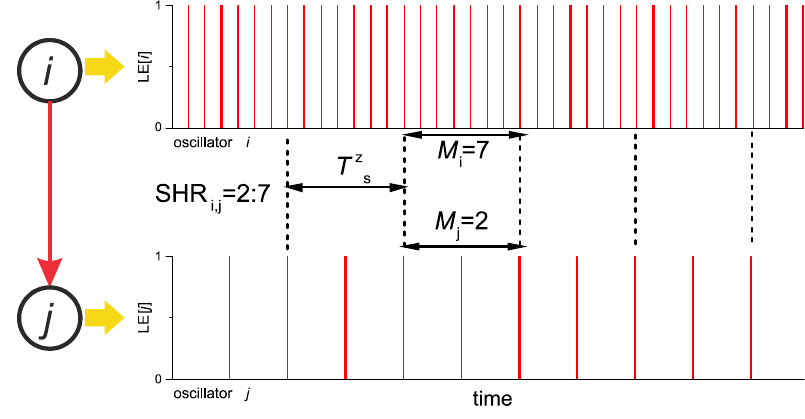
Figure 3. Arrays LE[ i ][ t ] and LE[ j ][ t ] for two oscillators.